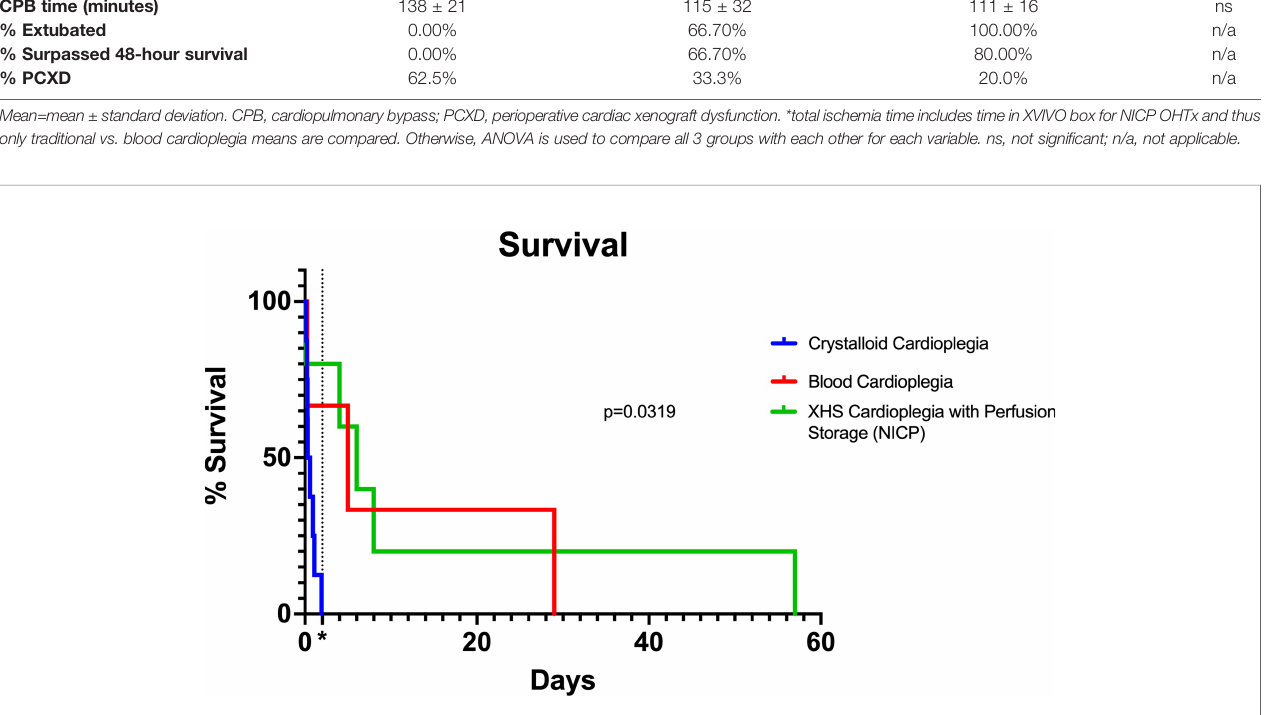
FIGURE 1 | Kaplan Meier curve comparing traditional, blood cardioplegia and NICP preservation methods. P-value calculated by Log-rank (Mantel-Cox) test. *=48 hours (2 days) after transplantation, indicating survival beyond PCXD.